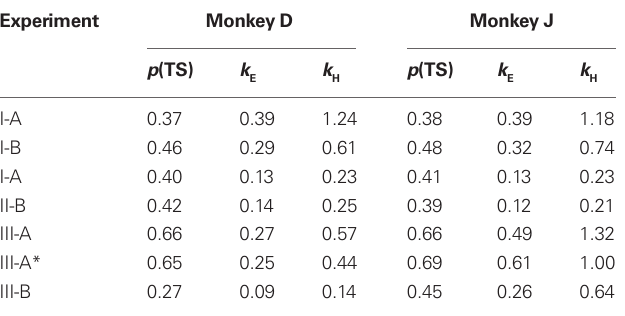
Table 2 | Probability of choosing small reward target (TS) and the value of k parameters for the exponential ( k functions.